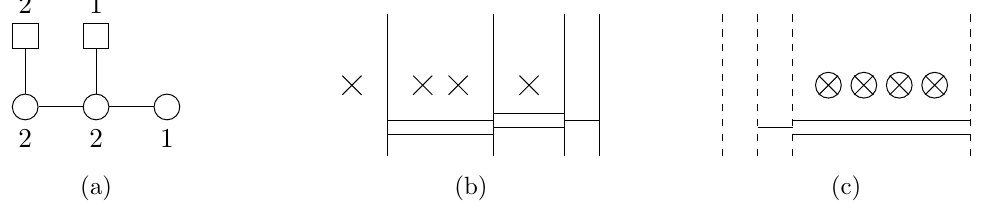
Figure 9. Model with moduli space: M C = (cid:22) O nilpotent orbit of g = sl (4). (a) Quiver. (b) Coulomb branch. (c) Higgs